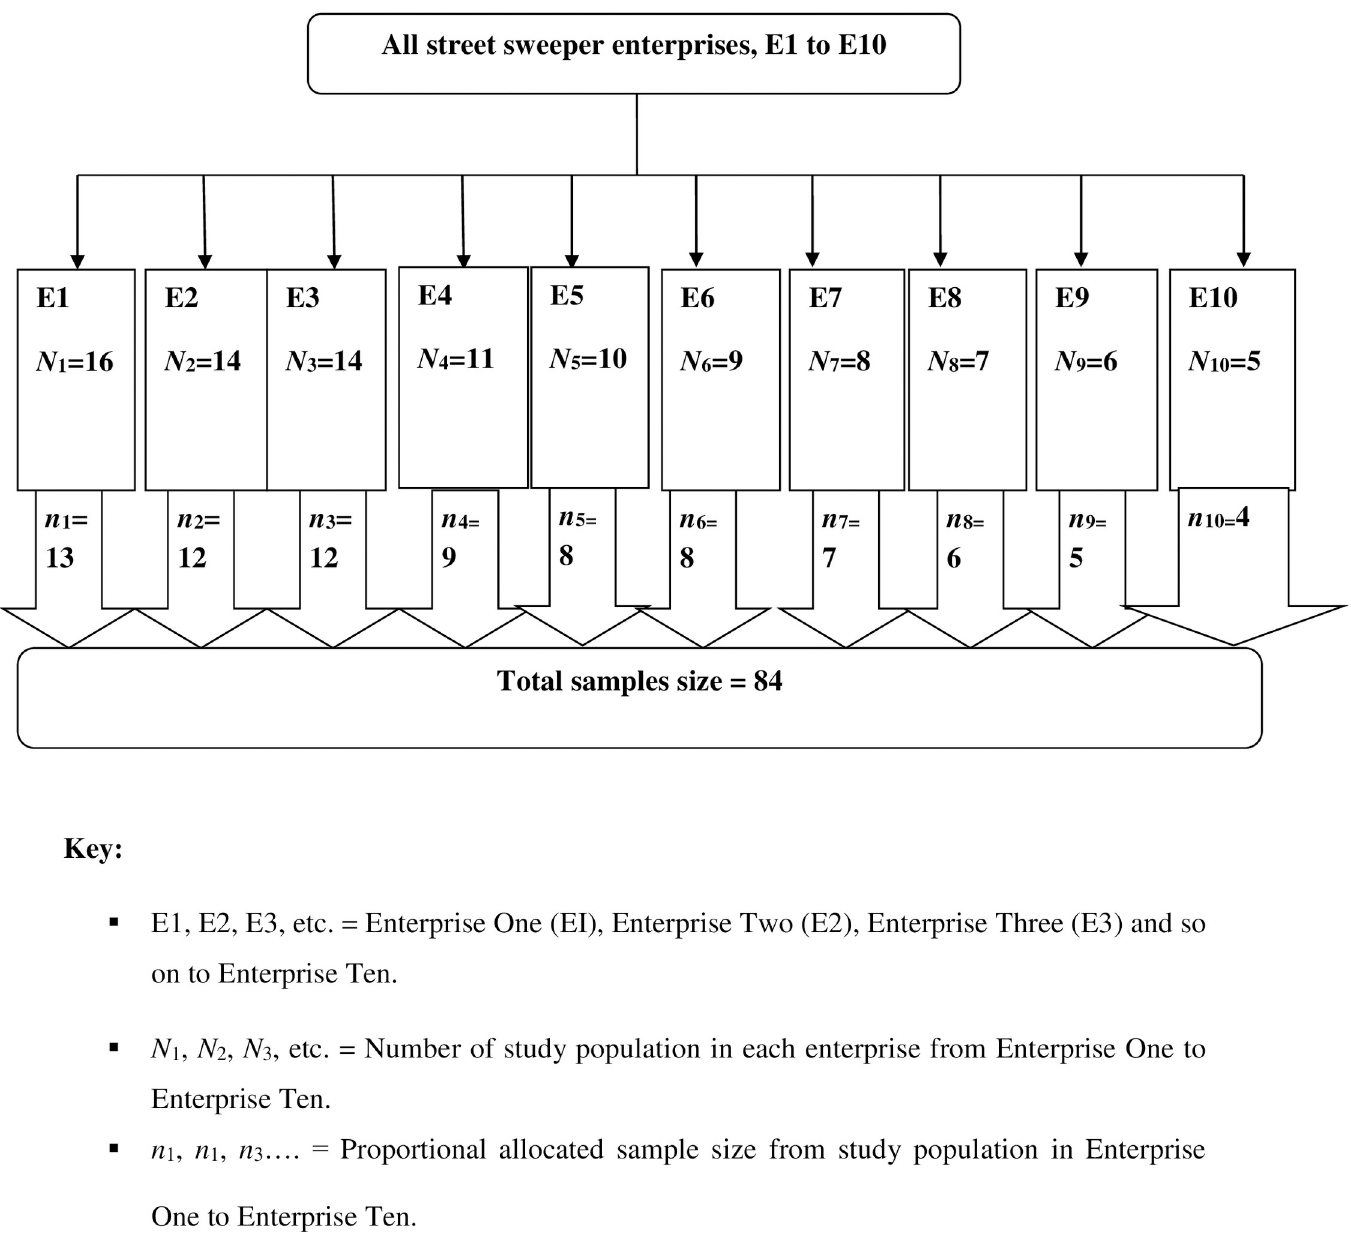
Fig 2. Proportional allocation of sample size among enterprises of street sweepers in Dessie City, Ethiopia, March to May 2018.